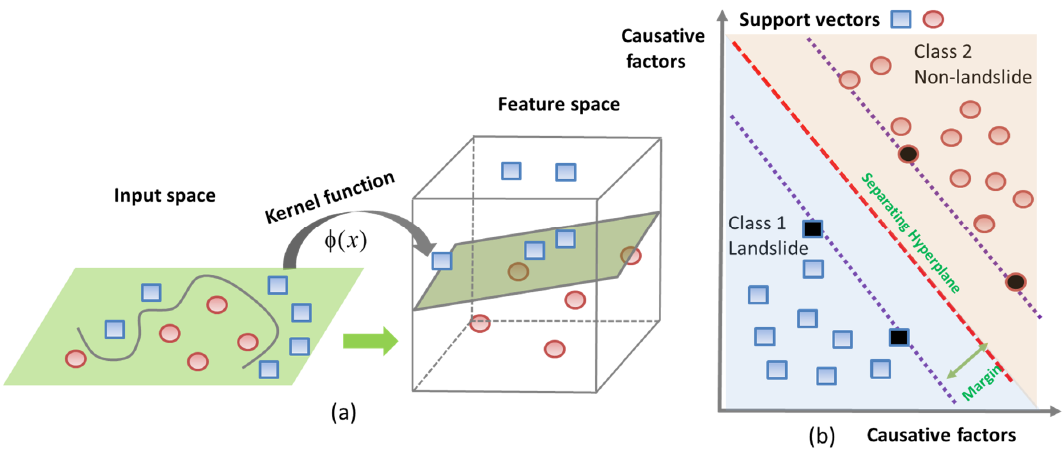
Figure 7. Illustration of support vector machine (SVM) principle: ( a ) Input space is mapped to the feature space with the help of a kernel function; ( b ) Separating hyperplane and margin for landslide classification.